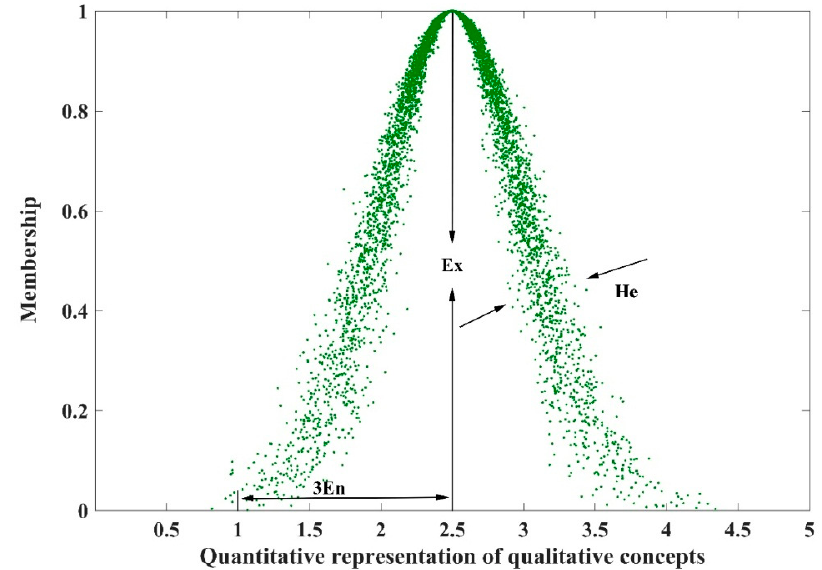
Figure 2. Three digital features of the cloud model.